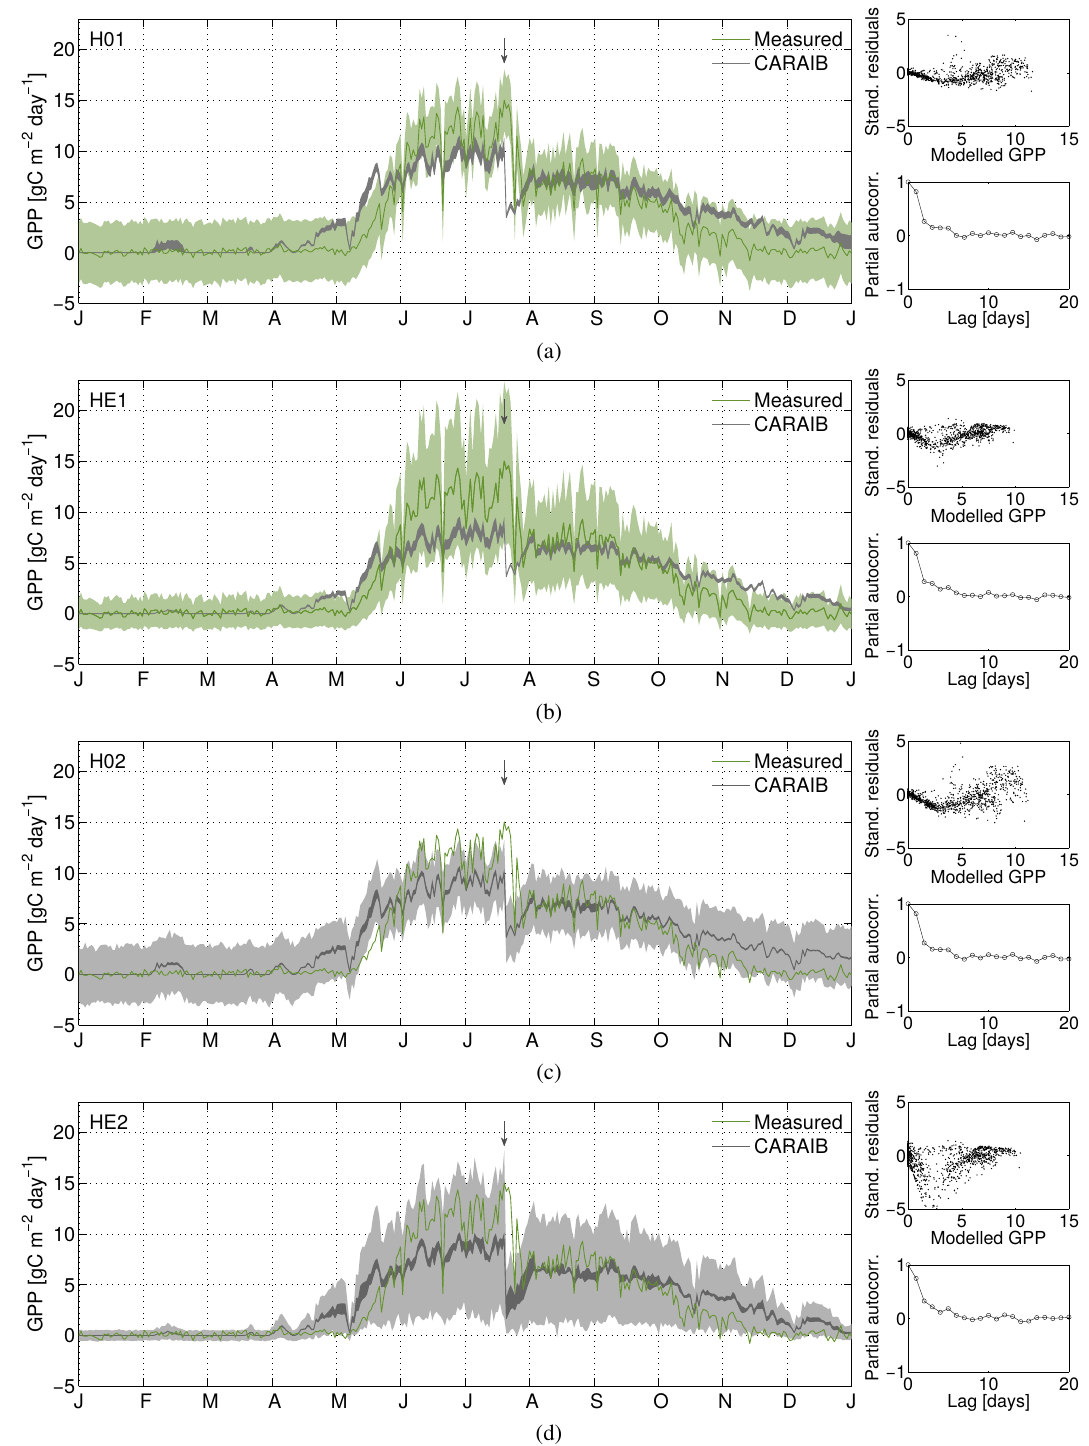
Figure 5. Measured and modelled GPP (gCm − 2 day − 1 ) at the Monte Bondone site in 2004 for the fixed homoscedastic HO1 (a) and heteroscedastic HE1 (b) , inferred homoscedastic HO2 (c) and heteroscedastic HE2 (d) inversions. The measured GPP is depicted with a constant (a) and variable (b) uncertainty range. For the HO2 and HE2 inversions, the 95% total predictive uncertainty interval is depicted using the light grey shaded areas. Standardized residuals and partial autocorrelation of residuals of GPP over the full simulation period are depicted to the right of each